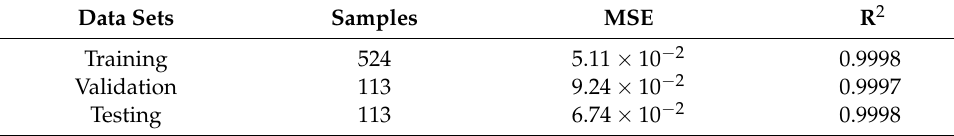
Figure 12. Variation of MSE for different epochs considering different data sets Table 2. ANN performance (variation of MSE and R 2 ) for different data